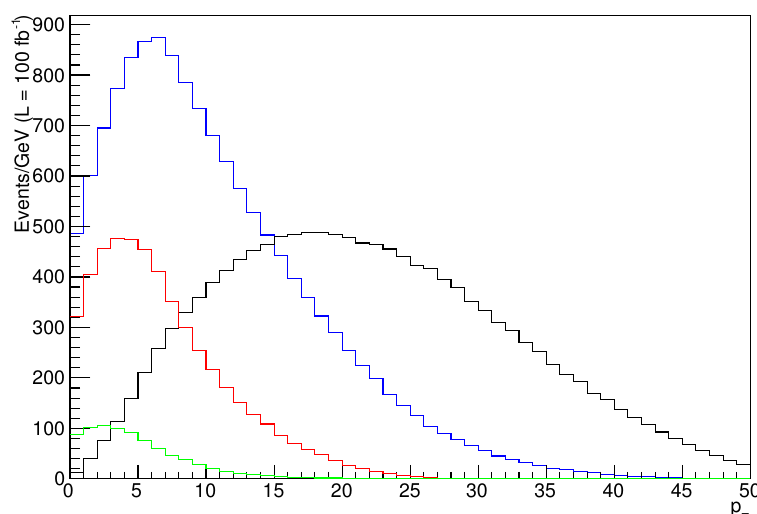
Figure 8. Distributions of the leptonic transverse momentum. The colours black, blue, red and green correspond respectively to the momentum distributions of the four leptons ordered in decreasing p T